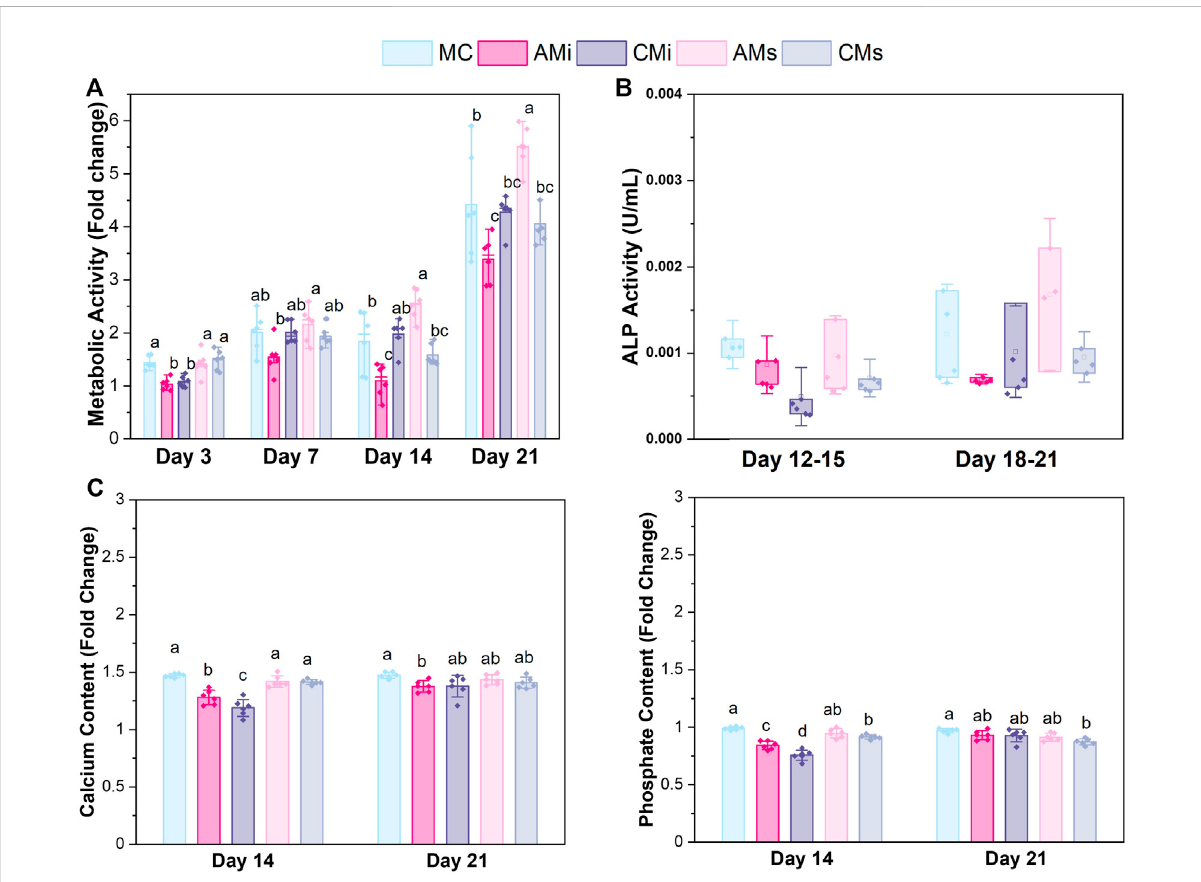
FIGURE 3 hMSCs cultured on scaffold variants for 21 days. (A) Metabolic activity measured by a non-destructive alamarBlue ® assay over the course of 21 days expressed as a fold change to a day 0 control ( n = 6). Different letter indicated signi fi cance at a level of p < 0.05 within the same day. (B) Cell dependent bone formation measured by alkaline phosphate (ALP) activity assay pooled from scaffolds across 15 and 21 days ( n = 6). (C) Amounts of calcium and phosphate produced by hMSCs on days 14 and 21 measured by inductively coupled plasma (ICP) mass spectroscopy ( n = 6). Different letter indicated signi fi cance at a level of p < 0.05 within the same